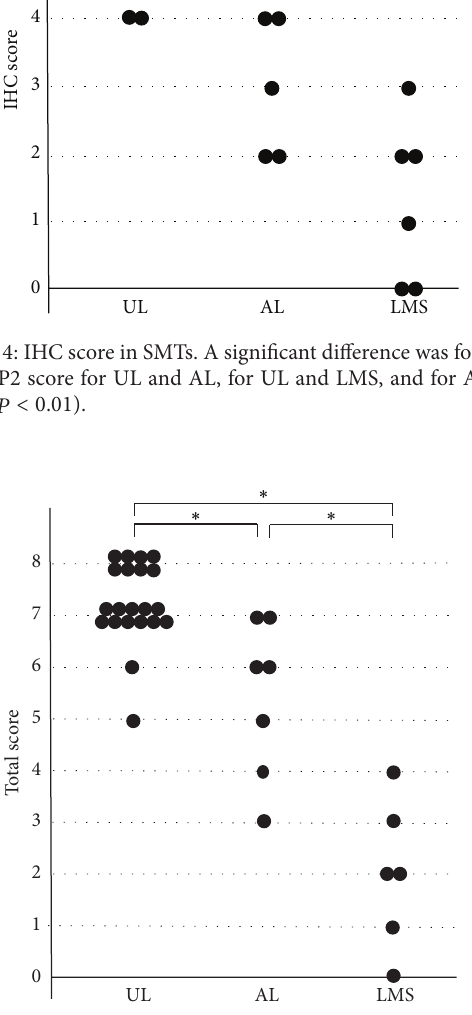
Figure 5: Total score in SMTs. A significant difference was found in the LMP2 score for UL and AL, for UL and LMS, and for AL and LMS ( ∗ 𝑃 < 0.01